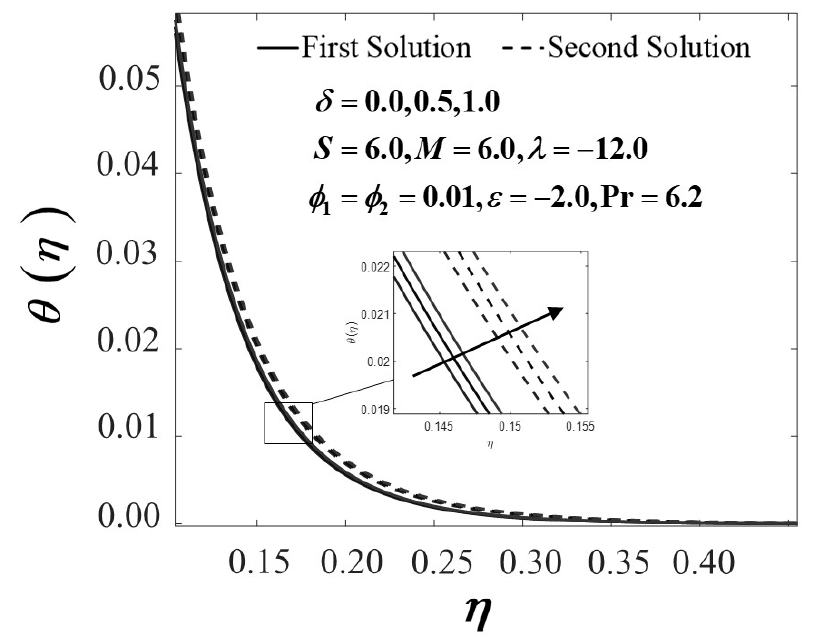
( ) θ η with 0.0,0.5,1.0 δ=